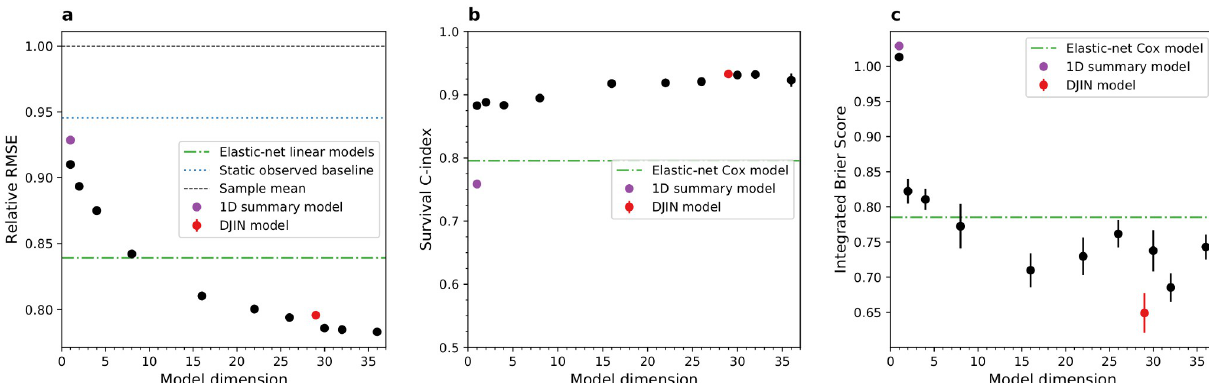
Fig 3. Latent space model performance vs dimension. Black points show latent space models of various dimension, red points show the DJIN model, green lines show the elastic net linear models. The purple point shows the 1D summary model described in S1 Text, which includes the information from the auxiliary background variables u within the latent state, rather than as a separate input in the model (see S7 Fig for more detail). Black points include t 0 as a separate input in addition to z . Points indicate the mean of 10 independent fits of the models, and error bars represent standard error of mean u t 0 (often smaller than point size). a) RMSE for health predictions, relative to predictions with the population average (black dashed line). (Lower is better). b) Survival C-index. (Higher is better). c) Integrated Brier score for survival. (Lower is better).